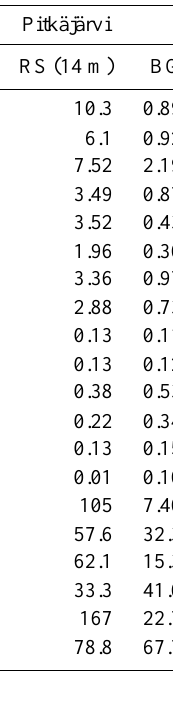
Table 2. Mean pollutant concentrations along with standard deviations (SD) at the highway (HW), roadside (RS), and background (BG) at the four sites. The distance from the curb to the exact measurement location is indicated in the brackets following RS. CN was measured by the CPC, BC by the aethalometer and Org, NO 3 , SO 4 and NH 4 by the